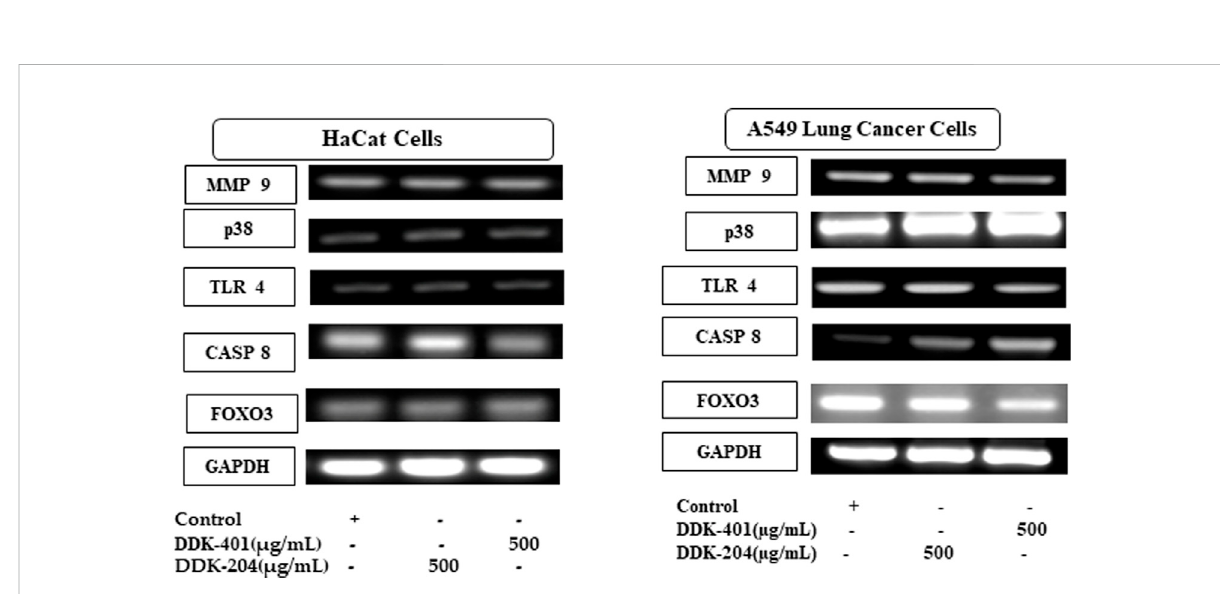
FIGURE 7 In vitro validation of the selected candidate gene expressions in normal (HaCaT) and lung cancer (A549) cell lines by RT-PCR.